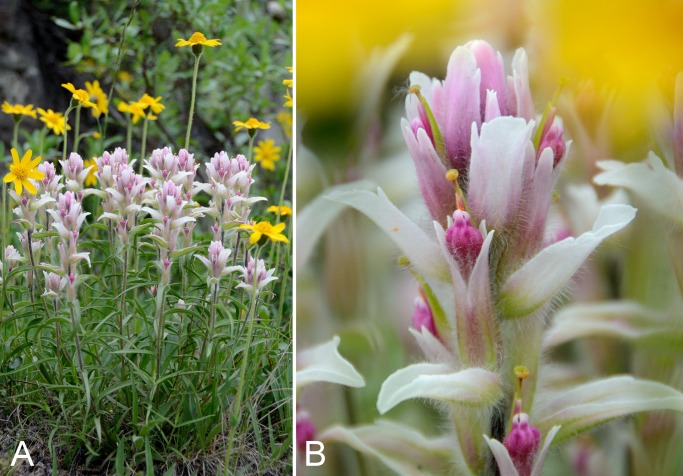
Castilleja elegans.(A) Habit, vicinity of Kugluktuk, Nunavut, 26 July 2014. (B) Inflorescence, vicinity of Kugluktuk, Nunavut, 26 July 2014. Photographs by R. D. Bull.